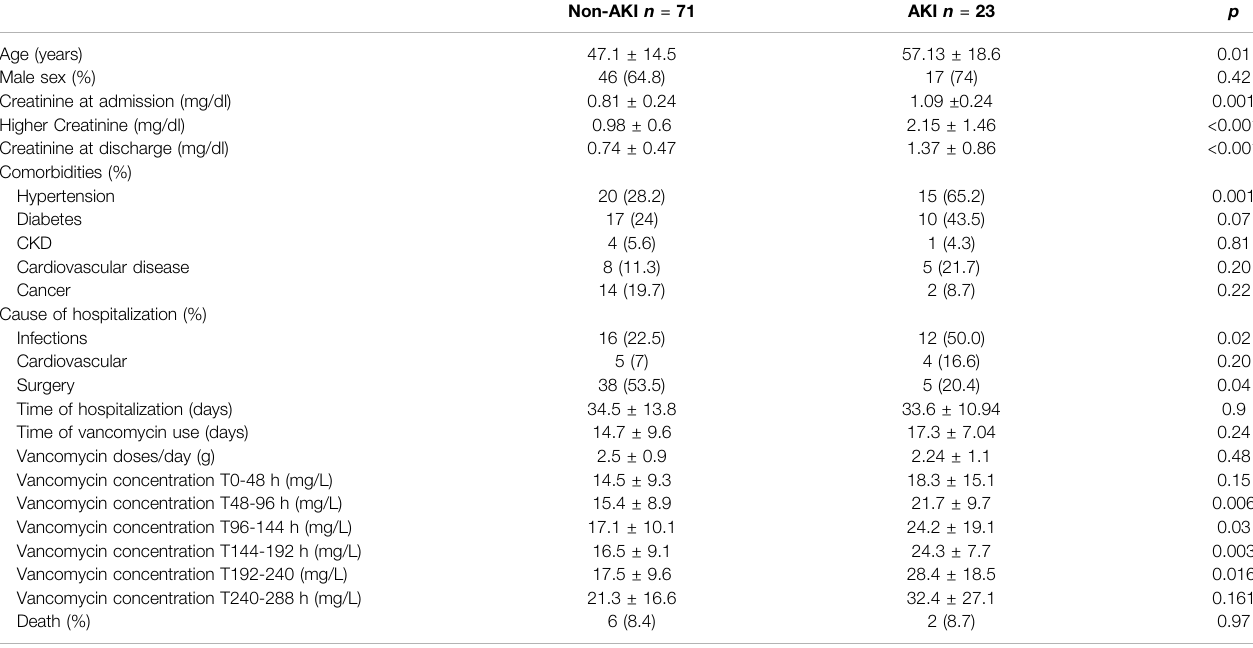
TABLE 1 | Patients demographics and clinical characteristics during hopitalization at wards.